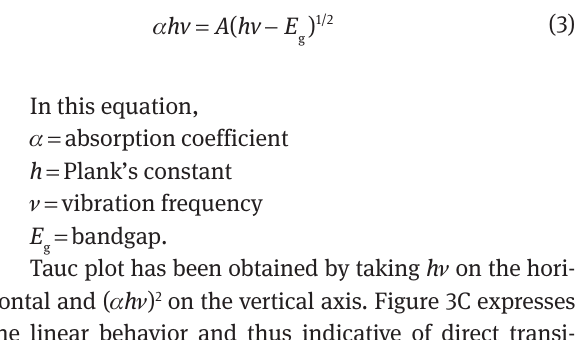
metallic ions and polyphenols consequently giving rise to reduction of metallic ions to metallic atoms by extract [26]. XRD pattern of Ag:ZnO NPs has exhibited hexagonal wurtzite geometry of crystals with an average crystallite